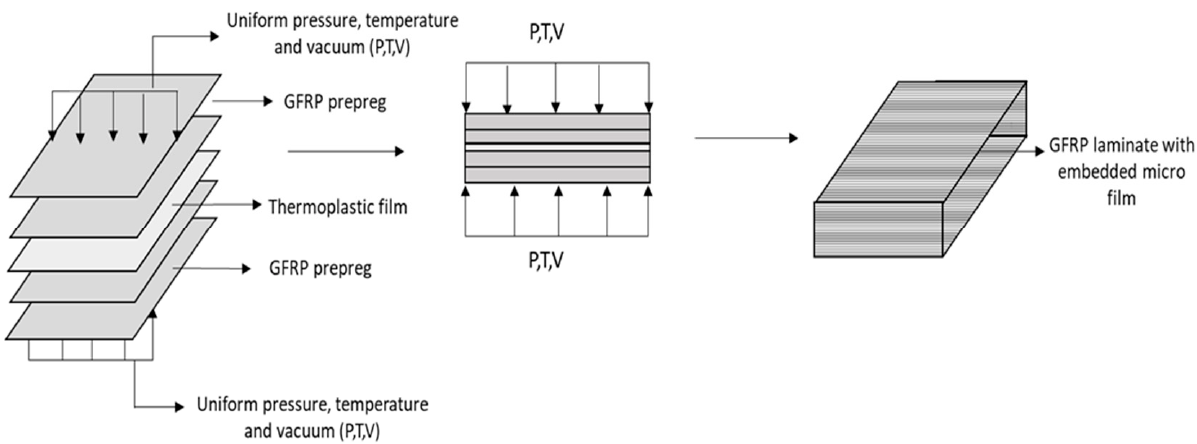
Figure 3. GFRP laminate manufacturing schematic.